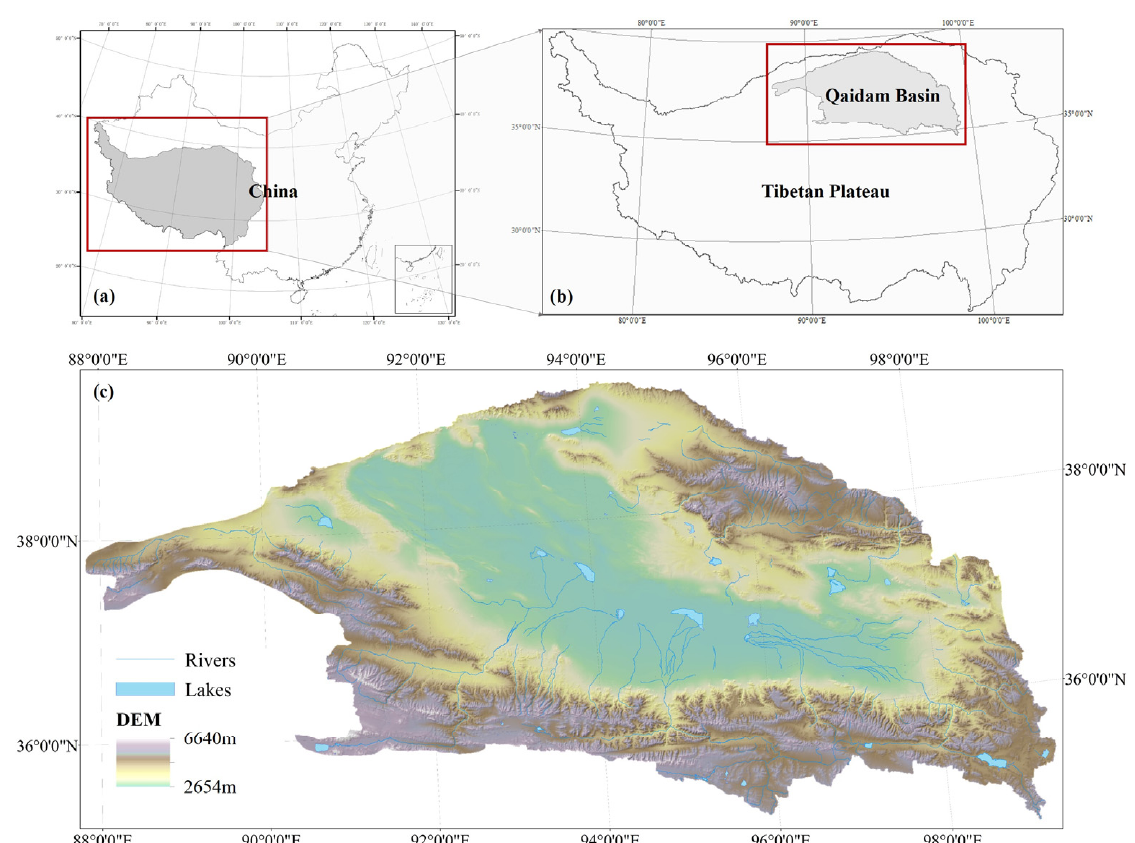
Figure 1. The geographical environment of the study area: ( a ) The Tibetan Plateau (in the red box) is located on the western China and ( b ) the study area, the Qaidam Basin (in the red box), is located on the northeastern Tibetan Plateau. ( c ) The elevation in the Qaidam Basin varies from 2654 m to 6640 m. The rivers rise from the surrounding mountainous area, and the lakes are mainly distributed in the inner basin.